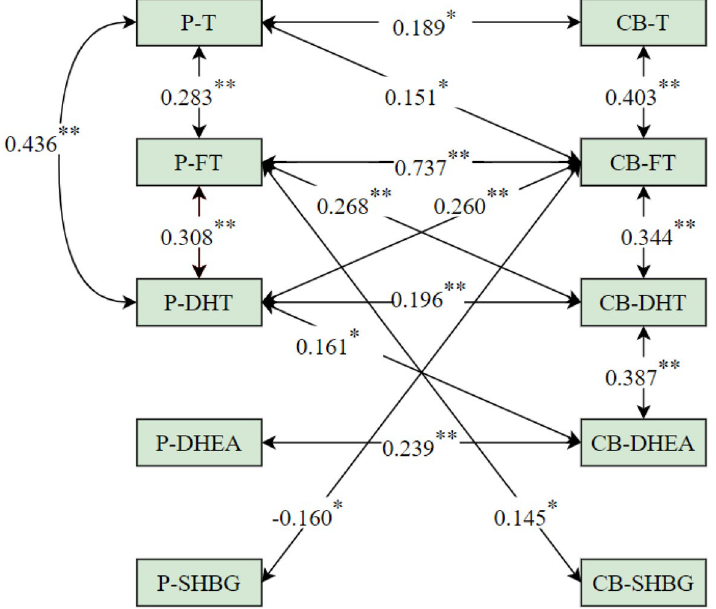
Figure 2. Relationships between prenatal androgens and cord blood androgens in male neonates. Notes: P-T prenatal testosterone, P-FT prenatal free testosterone, P-DHT prenatal dihydrotestosterone, P-DHEA prenatal dehydroepiandrosterone, P-SHBG prenatal sex hormone binding globulin, CB-T cord blood testosterone, CB-FT cord blood free testosterone, CB-DHT cord blood dihydrotestosterone, CB-DHEA cord blood dehydroepiandrosterone, CB-SHBG cord blood sex hormone binding globulin; * P < 0.05; ** P <